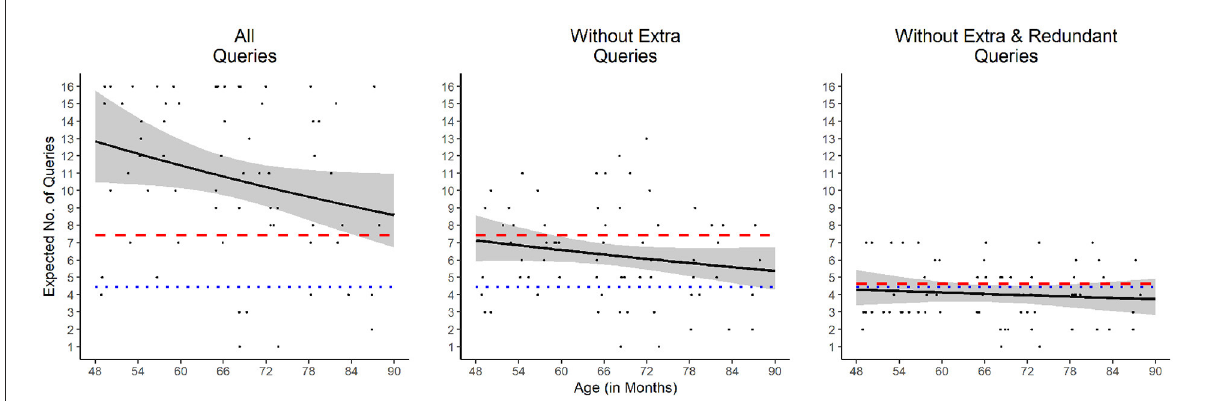
FIGURE2 Expected number of queries as a function of age. The shaded areas represent 95% confidence intervals. The blue dotted lines represent the performance of the simulated optimal agents, and the red dashed lines represent the performance of the simulated random agents. Note that the performance of the simulated optimal and random agents are always significantly different from each other. Only the left figure was fitted by a Negative Binomial model, while the other figures were fitted by Poisson